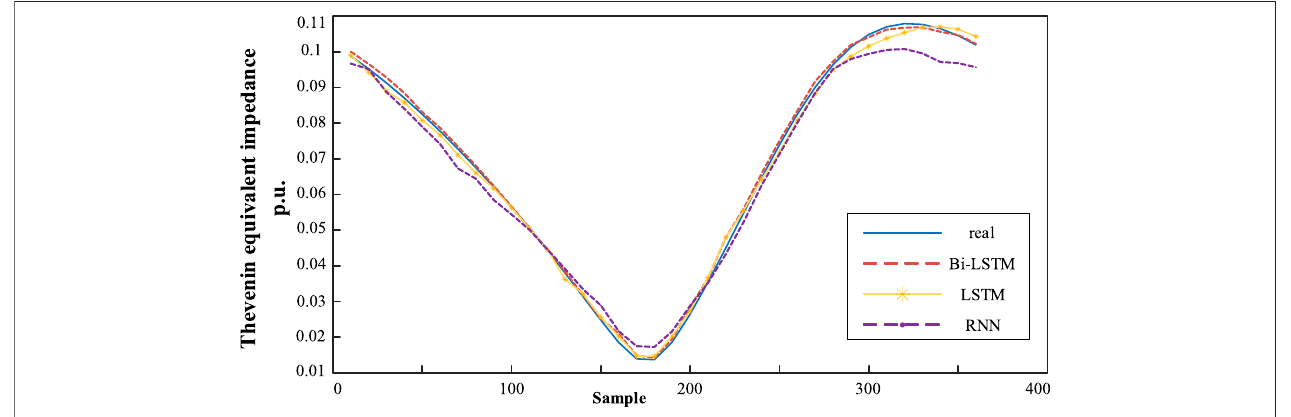
FIGURE 10 | Comparison of Thevenin equivalent impedance parameters for different learning methods.